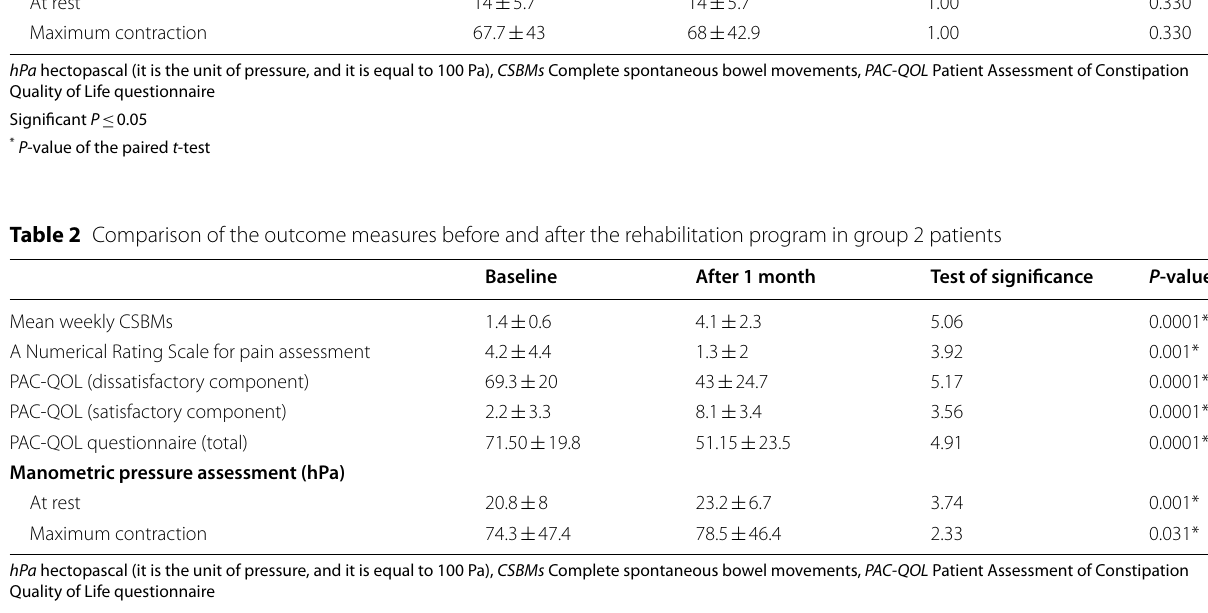
hPa hectopascal (it is the unit of pressure, and it is equal to 100 Pa), CSBMs Complete spontaneous bowel movements, PAC-QOL Patient Assessment of Constipation Quality of Life questionnaire Significant P 0.05 ≤ * P -value of the paired t